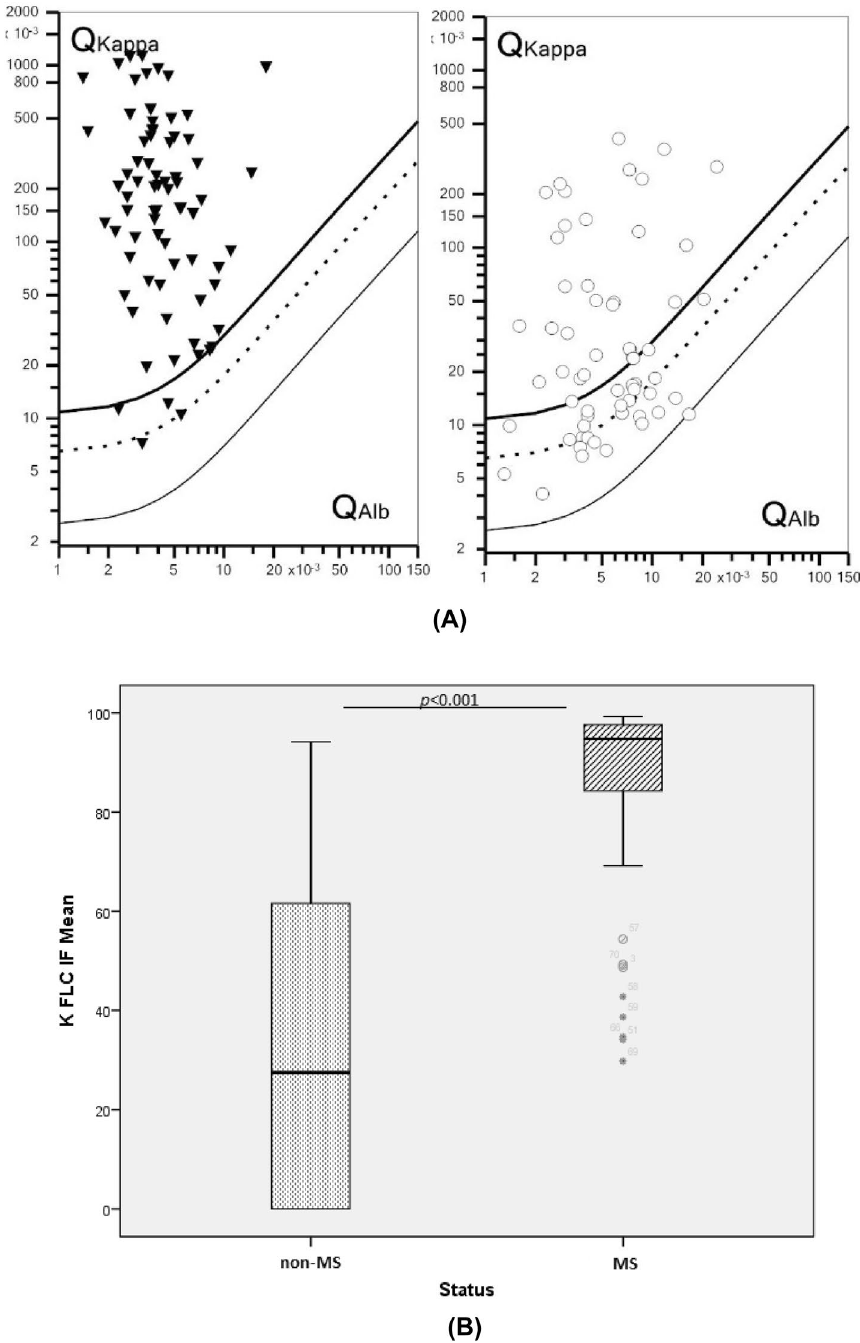
Figure 5. Comparative presentations of κ-FLC-related parameters in multiple sclerosis (MS) patients and controls (non-MS patients) according to the software “FLC-κ statistics and graphic program”: ( A ) κ-FLC Reibergrams showing the relation between the CSF/serum κ-FLC quotient (Q kappa) and the CSF/serum albumin quotient (Qalb) for each patient. An intrathecal synthesis of κ-FLC is revealed by a Q kappa value above the upper line, depicting the hyperbolic border line Q kappa (lim). The Q kappa mean is represented by the dashed line and the lower limit of the reference range (Q kappa low) by the lower line. ( B ) Comparative distribution of κFLC intrathecal fraction (IF) in MS and non-MS groups using U test of Mann–Whitney. Horizontal solid lines indicate